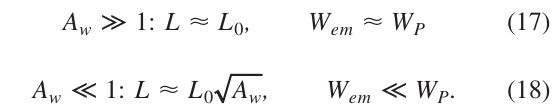
FIG. 8. (Color) Optimum dependence of the plasma density on the traveled of 10 in (19) is chosen somewhat arbitrary to emphasize the importance of a low energy spread. The average (over the whole interaction length) plasma density is controlled by the distance between the driver and the witness; the shorter